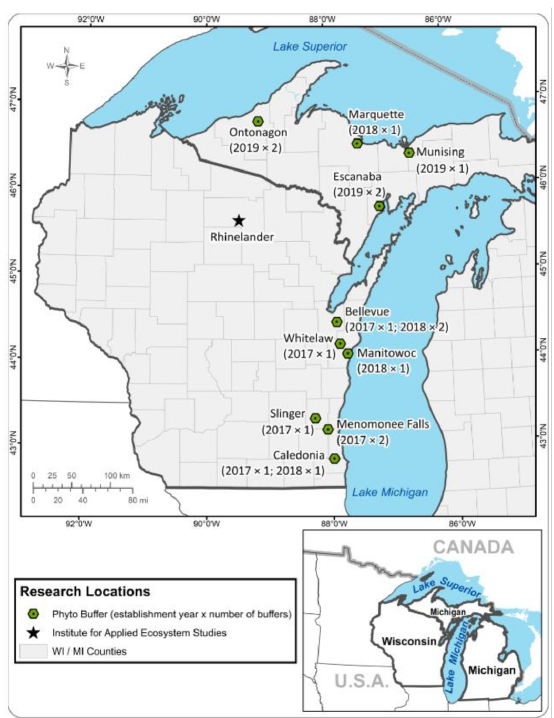
Figure 1. Regional phytotechnologies network consisting of sixteen phytoremediation buffer systems (i.e., phyto buffers) established in 2017 ( × 6 phyto buffers), 2018 ( × 5), and 2019 ( × 5) in the Lake Superior watershed of the Upper Peninsula of Michigan, USA and the Lake Michigan watershed of eastern Wisconsin, USA. From Zalesny et al.